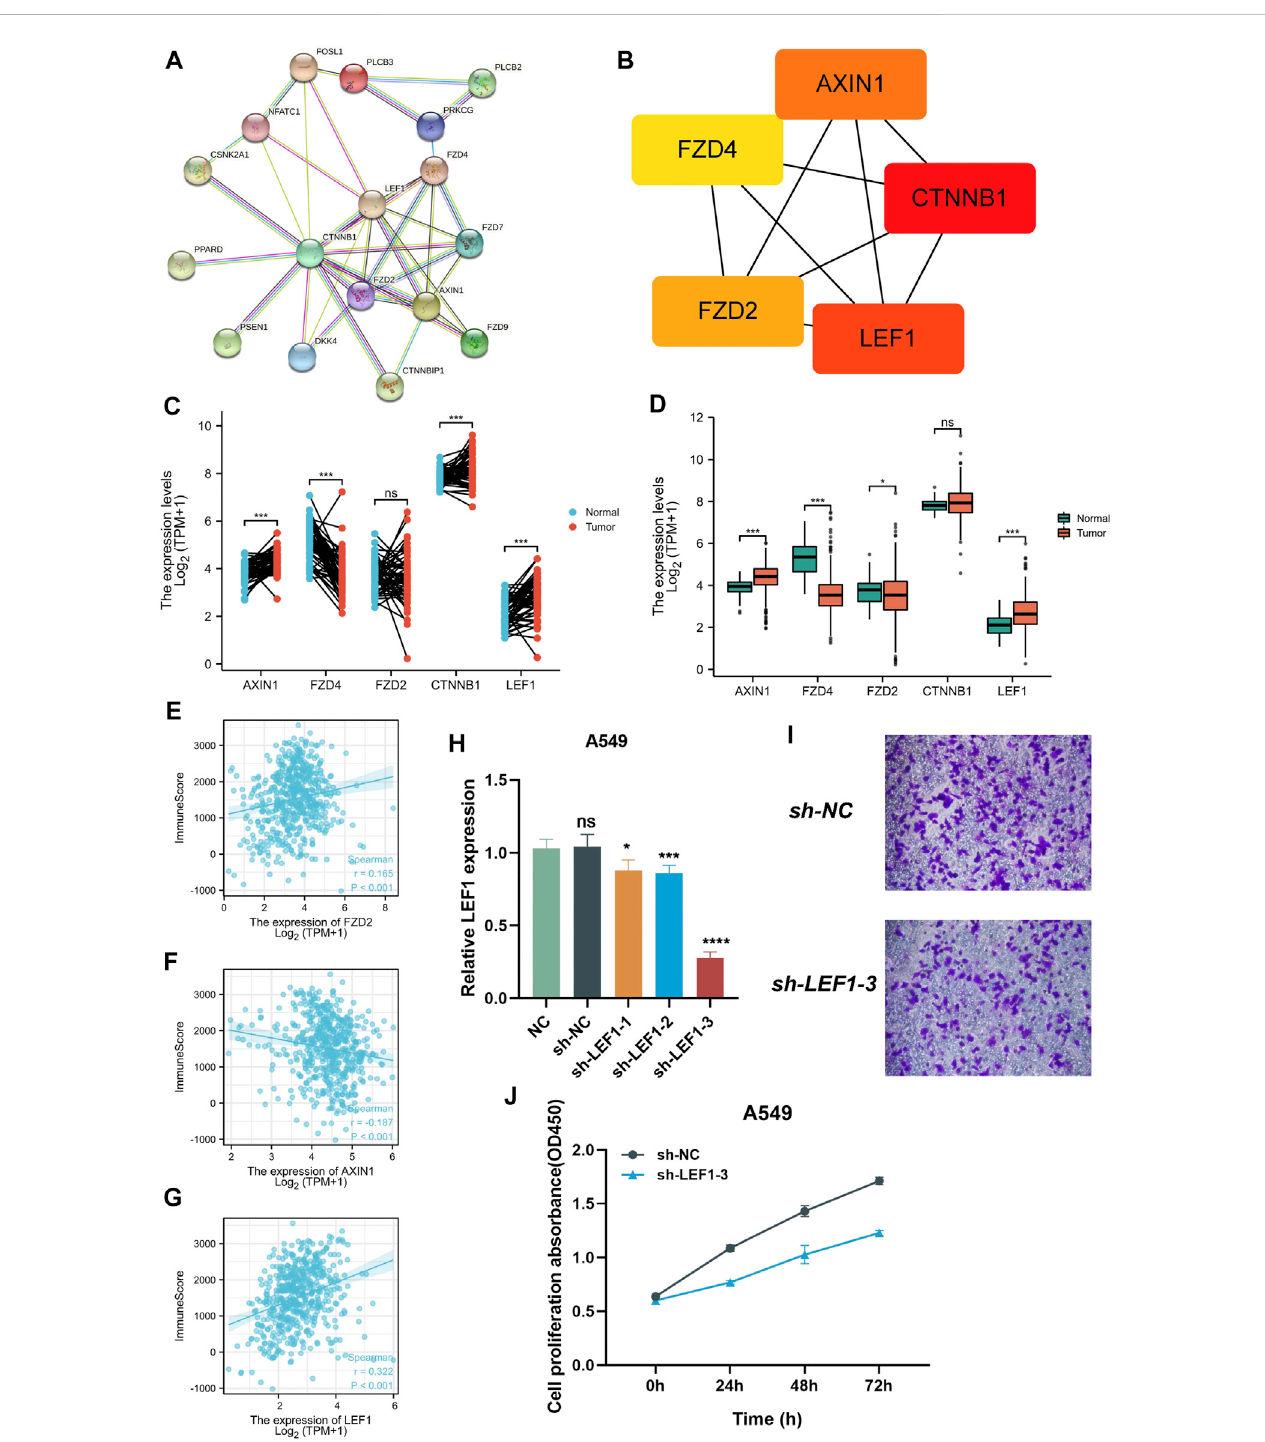
FIGURE 7 Collection of key prognostic genes. (A) Protein-protein interaction network diagram of 18 target genes (B) MCC method was performed to identify the keyTop5molecularintheprotein-proteinInteractionnetwork. (C,D) theexpressionlevelof5keyprognosticgenesinnormaltissuesandtumortissues (E – G) the Correlation between 5 key prognostic genes and immune scores. (H) qPCR assay detect the expression of LEF1. (I) Transwell assay detect the invasion of the A549 cell line after knockdown LEF1. (J) CCK-8 assay detect the proliferation of the A549 cell line after knockdown